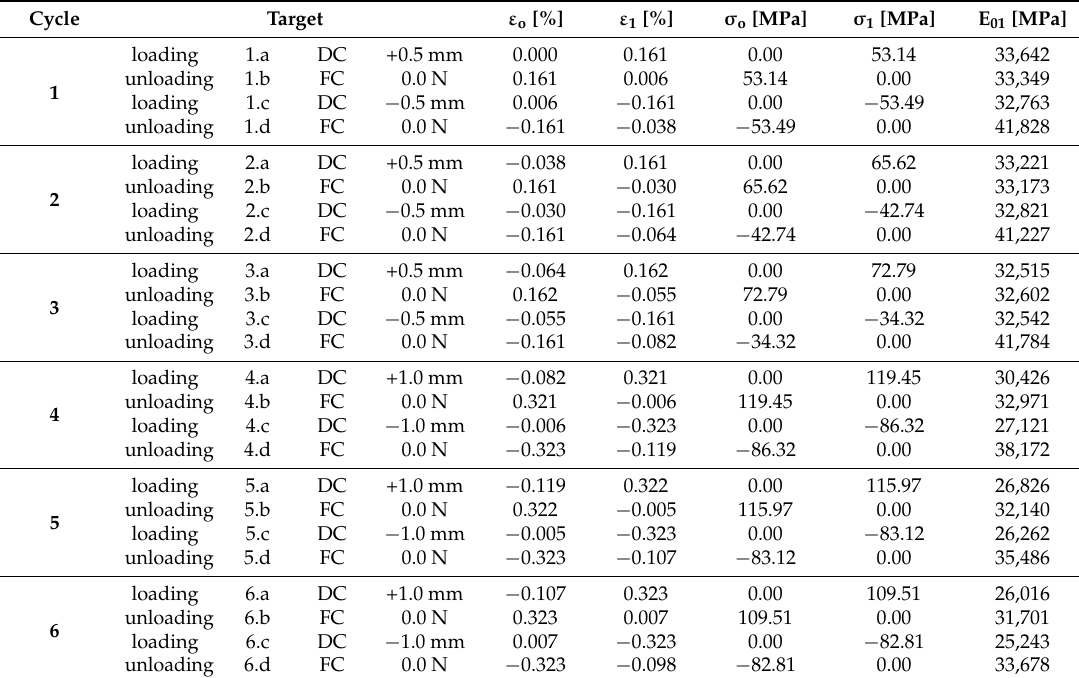
Table 5. Preliminary tests (GFRP sample